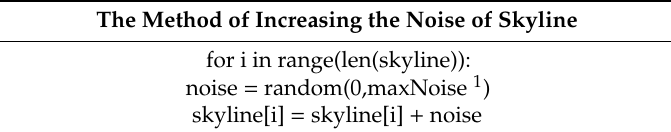
Table 6. The method of increasing the noise of a skyline (using Python).